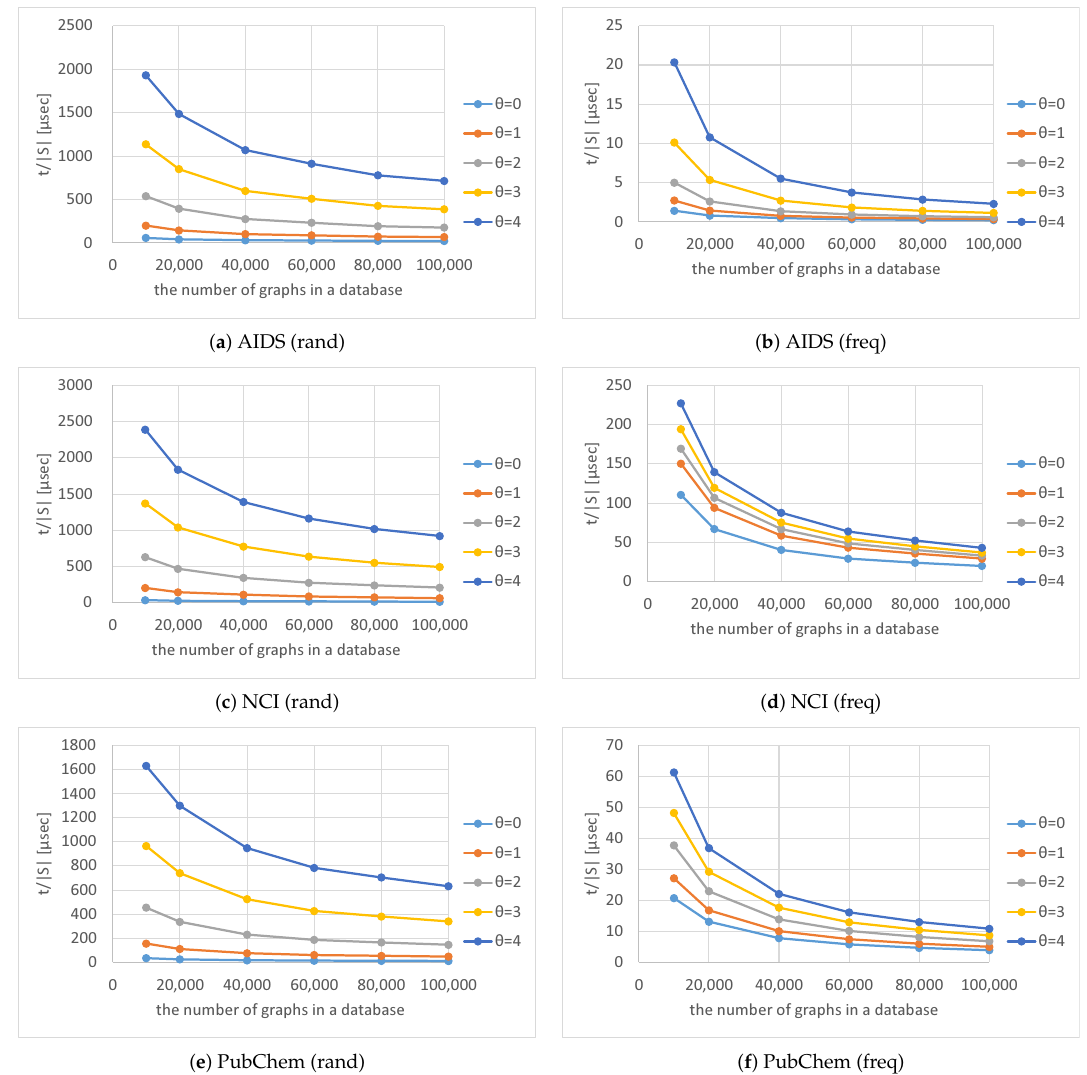
Figure 13. Computation time per solution t / | S | for various numbers of graphs | G | in a database and various thresholds θ